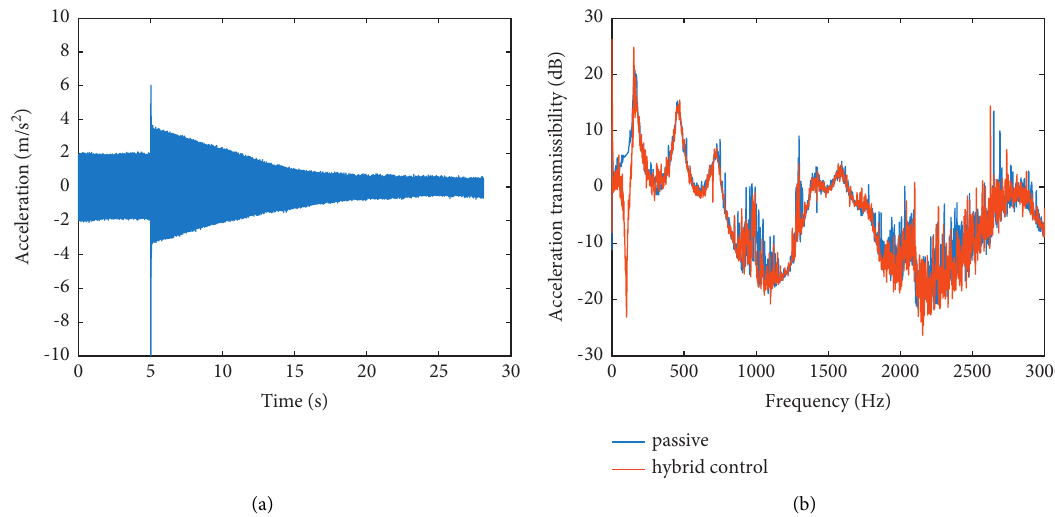
Figure 26: Experimental results of active and passive hybrid vibration control effect. (a) Right end acceleration. (b) Acceleration transmissibility.